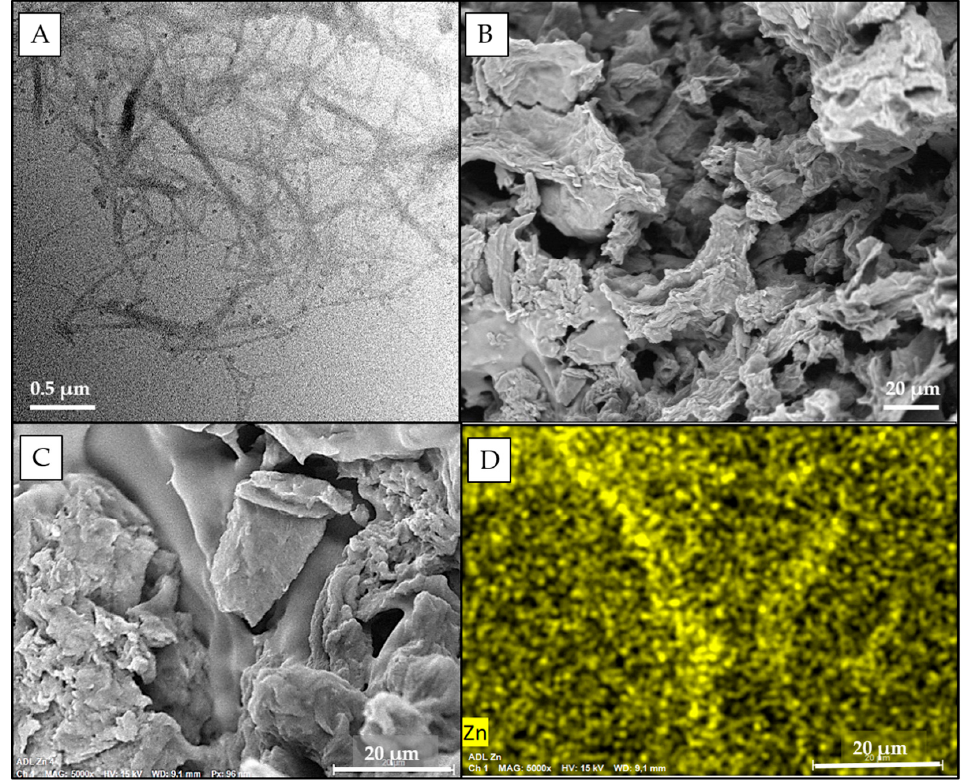
Figure 2. ( A ) TEM image of TOCNF; ( B ) SEM image of CNS powder before zinc decontamination activity; ( C ) SEM image of CNS powder after Zn adsorption; ( D ) SEM-EDS image of CNS after Zn adsorption clearly showing the presence of Zn on the nanosponge (yellow dots) .